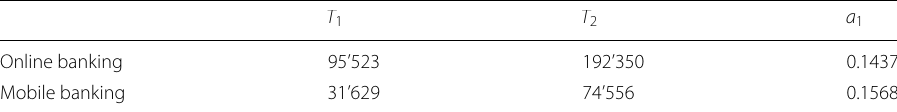
Table 5 Optimized values